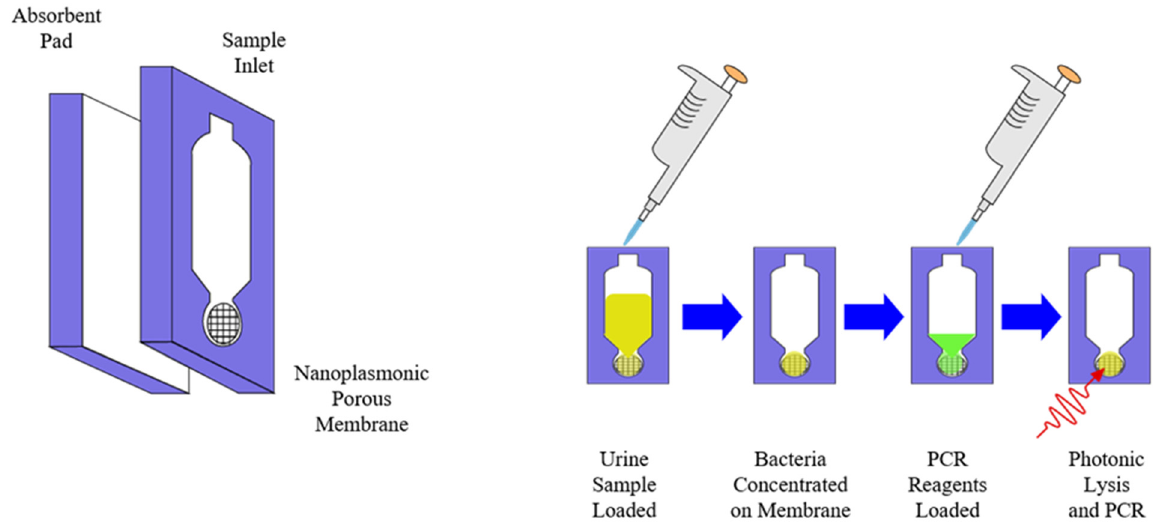
Figure 6. Cartridge-based diagnostic assay for urinary tract infections (UTIs) using a membrane and absorbent pad to separate pathogens from urine and then performing photonic lysis and polymerase chain reaction (PCR) in one step using a portable LED source. From Cho et al., 2019 [107].